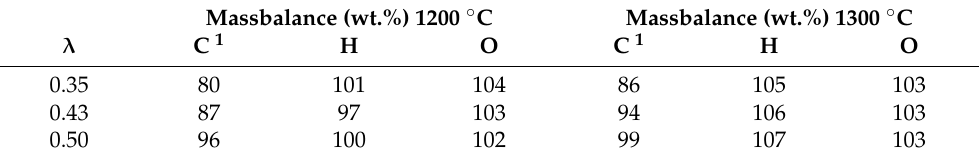
Table 5. The calculated mass balances for carbon, hydrogen, and oxygen from the gasification experiments. Massbalance (wt.%) 1200 ◦